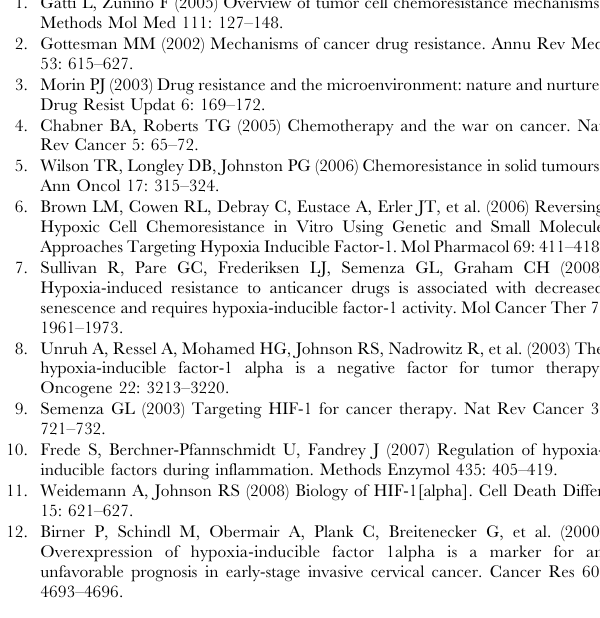
Figure 6. ROS as molecular mediator of the HIF-1 a effect on chemosensitivity in AGS KD cells. (A–D) AGS KD cells were pretreated for 16 h with different concentrations of the NADPH oxidase inhibitors diphenyleneiodonium (DPI) or apocynin. Proliferation of DPI-pretreated (A) or apocynin-pretreated (B) AGS KD cells 24 h after treatment with 10 m g/ml 5-FU under normoxic conditions (***, P , 0.001). Cell numbers are shown as percent of untreated cells. (C and D) The effect of DPI (C) and apocynin (D) on p53 and p21 protein levels was determined by immunoblot analysis using whole cell extracts of AGS KD cells treated for 24 h with 10 m g/ml 5-FU. (E) Proposed model for HIF-1-dependent regulation of chemosensitivity by ROS-induced modulation of p53. (left panel) Chemotherapy-induced response in HIF-1-competent cells. HIF-1 counteracts generation of ROS at the mitochondrial level. Decreased ROS levels in turn abate activation of p53 and allow for cell cycle progression despite chemotherapy. Hence, HIF- 1-competent cells display a more chemoresistant phenotype. Ub, ubiquitin; P, phosphate. (right panel) Chemotherapy-induced response in HIF-1- deficient cells. Inactivation of HIF-1 leads to accelerated mitochondrial ROS generation. ROS are potent inducers of p53 and thus boost activation of p53 by chemotherapeutic agents. P53 in turn transactivates -among others - the cyclin-dependent kinase (CDK) inhibitor p21 and inhibits NF- k B activity. The combined activation of p53 and inhibition of NF- k B, result in apoptosis and/or senescence of HIF-1-deficient cells, hence a more chemosensitive